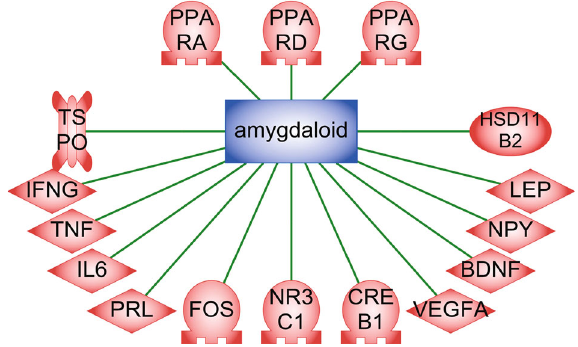
Figure 3: The association of proteins with amygdala. Relation type —